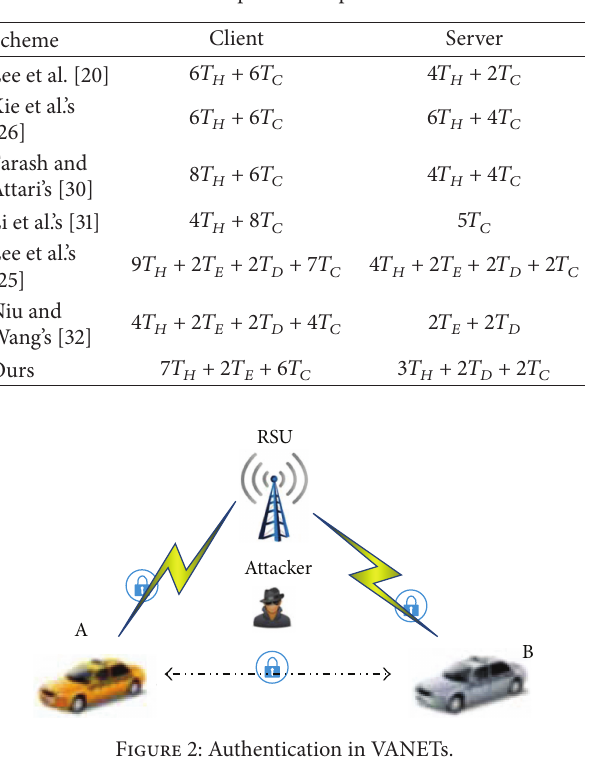
Table 2: Comparison on performance.